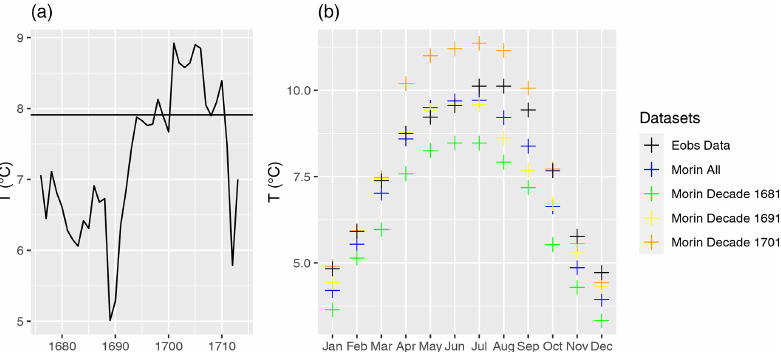
Figure A2. In panel (a) the mean DTR per month of the E-OBS data, of the different locations, and of the whole time period can be seen. In panel (b) the yearly mean DTR is plotted, and the horizontal line represents the mean of the reference period from 1961 to 1990 (E-OBS).